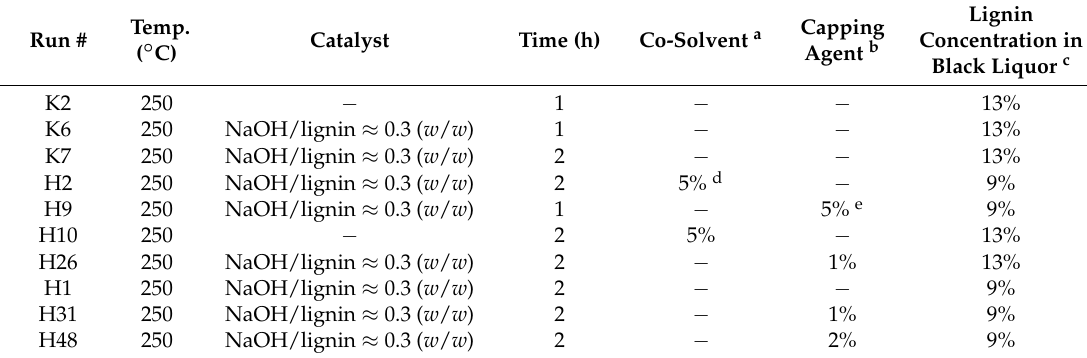
Table 3. Experimental run # and the associated reaction conditions for the depolymerization of lignin in black liquor at 250 ◦ C.